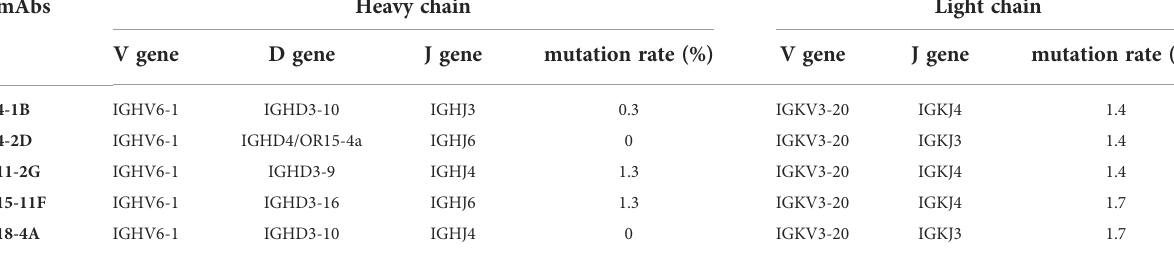
TABLE 1 Characterization of SARS-COV-2 neutralizing mAbs isolated from CAMouse HG mice. mAbs Heavy chain Light